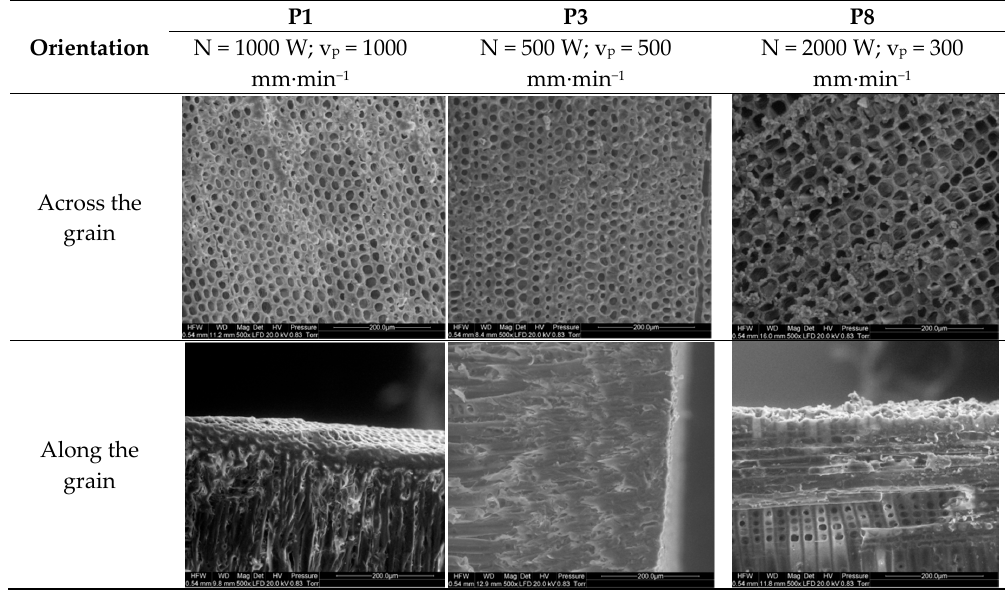
Figure 6. Surface structure of Scots pine samples laser-cut across and along the grain (trials P1, P3, and P8).